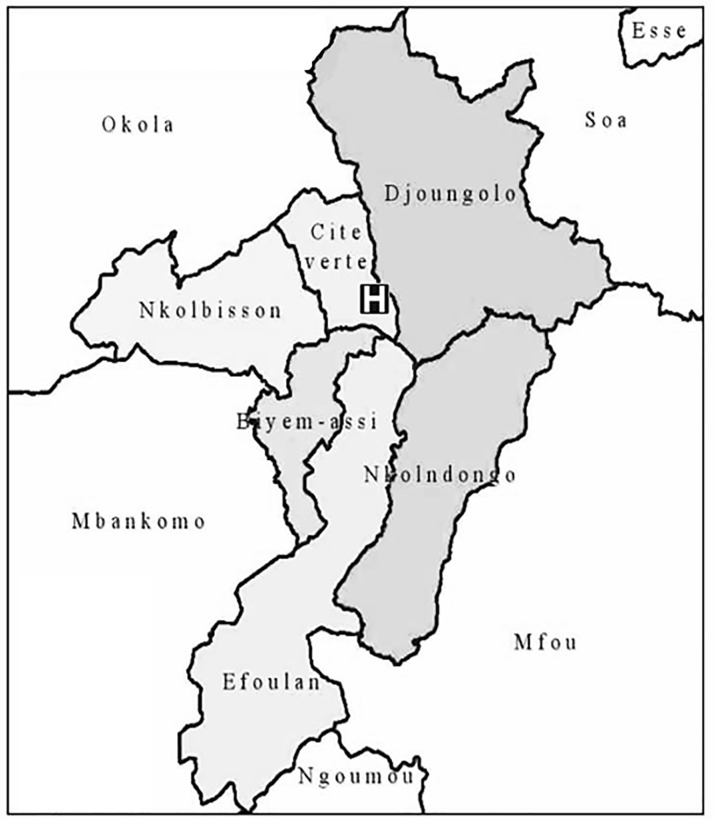
Six health districts of Yaoundé, Cameroon (Biyem assi, Cite verte, Djoungolo, Efoulan, Nkolbisson, and Nkolndongo).Centre des Urgences de Yaoundé (CURY), marked as “H” in the figure, is located in “Cite verte” health district. Reprinted from https://www.dhis-minsante-cm.org/portal/ under a CC BY license, with permission from Directorate of Disease Control, Epidemics, and Pandemics. Ministry of Public Health, Cameroon.